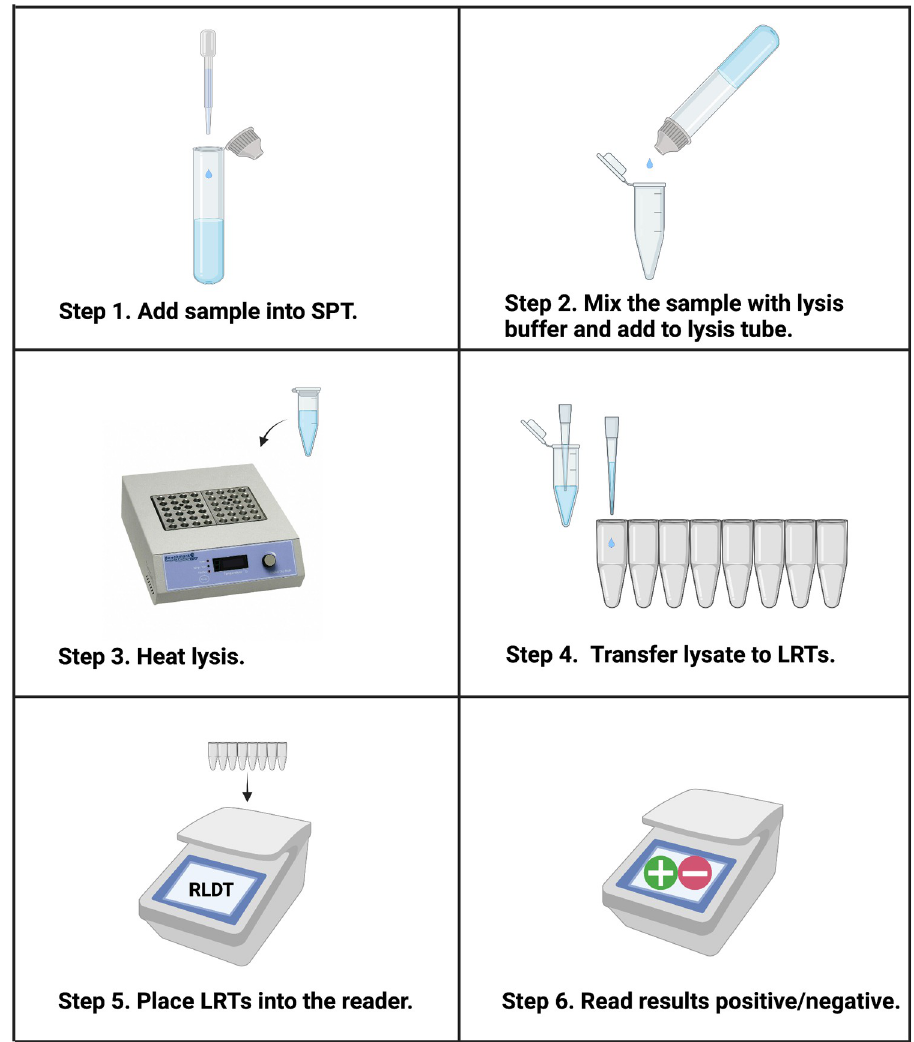
Fig 1. Workflow of ETEC and Shigella RLDT using RLDT kit. Step 1, using the fixed volume pipette provided in the kit, add a stool sample to the Sample Processing Tube (SPT) with lysis buffer. Step 2, Cap the SPT tube and mix by up and down. Squeeze the SPT tube to add the lysis buffer + stool sample to the lysis tube (1.5ml microfuge tube). Step 3, lysis tube is heated at 90˚C for 5 minutes in a heat block or water bath. Step 4, add 25 μ L of lysate to each tube of the lyophilized reaction tubes (LRT) strip using disposable fixed volume pipette. Step 5, place the LRTs in the reader. Scan the barcode for ETEC and Shigella RLDT program. Step 6, read results displayed on the screen after 40 minutes.